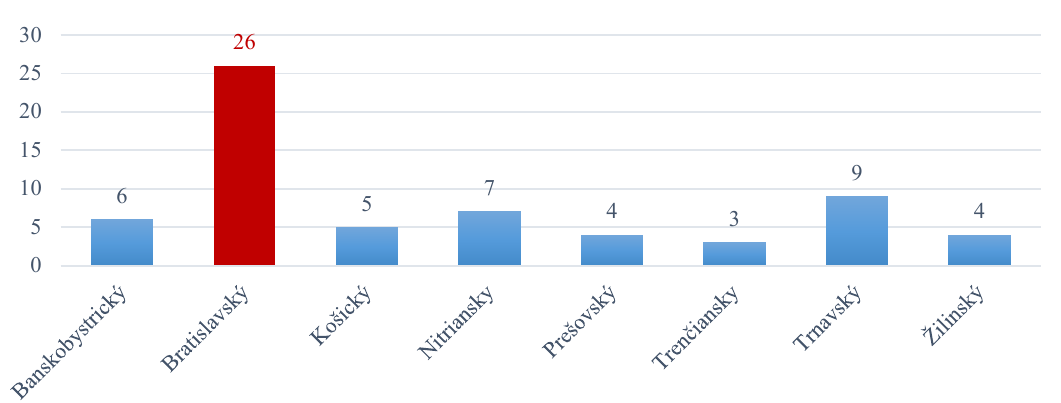
Figure 1 . Number of transport companies resided on one address